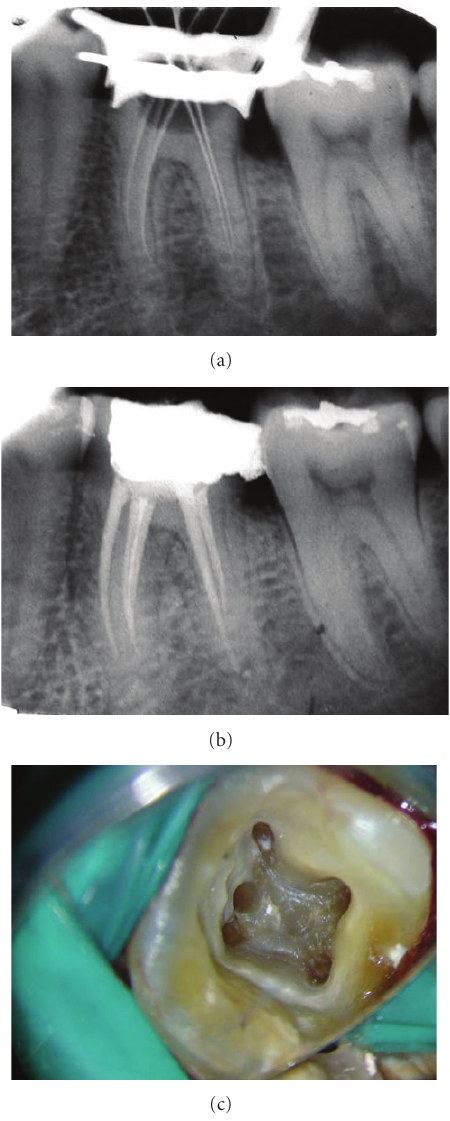
Figure 3: (a) Working length. (b) Obturation. (c) Clinical image.